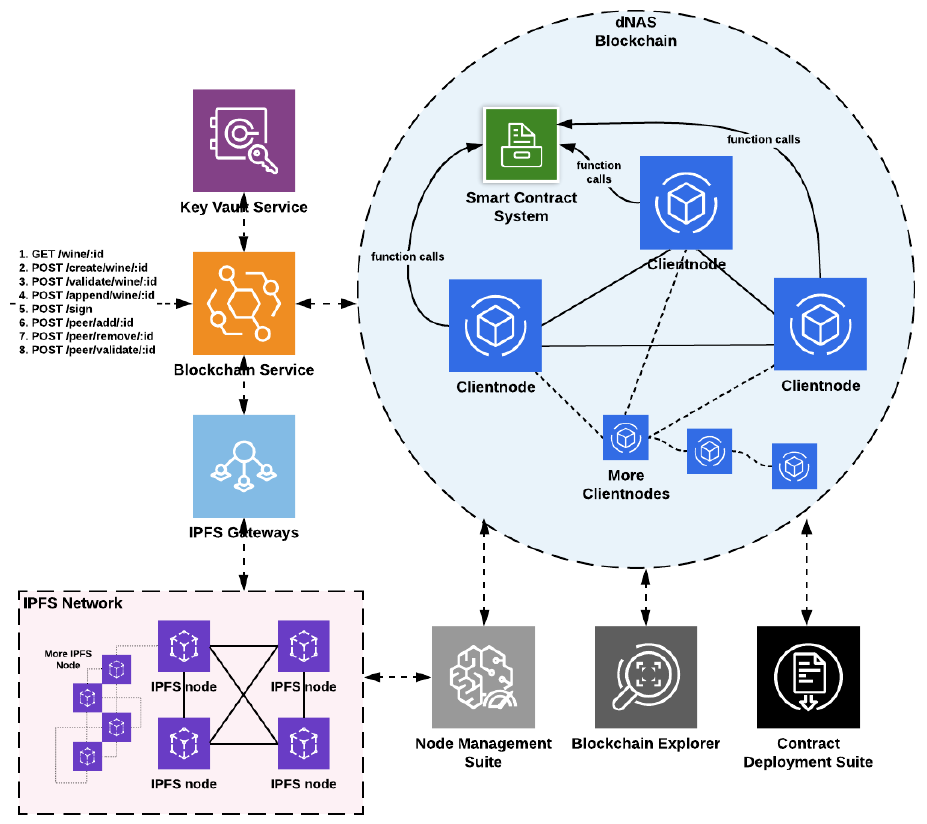
Figure 9. The Proposed Blockchain Interface of